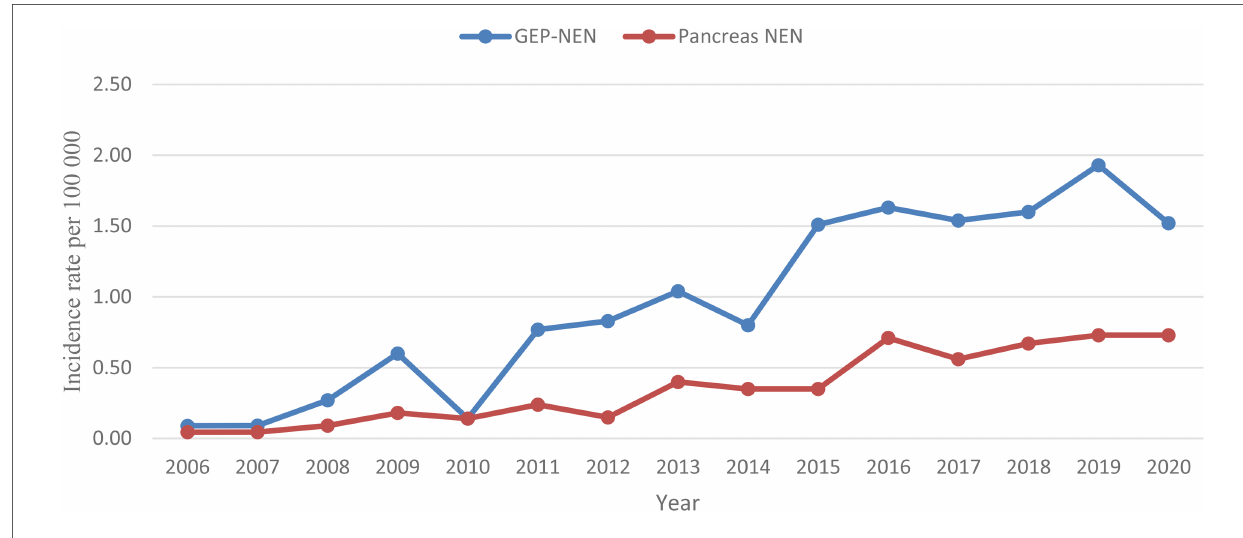
FIGURE 1 Age-standartized incidence rate of GEP-NEN and PNEN per 100,000